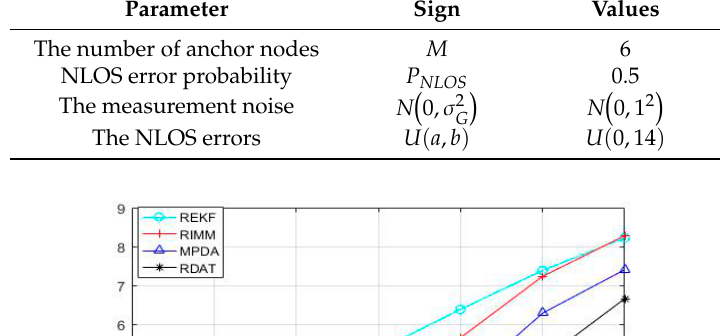
Table 2. Uniform distribution parameter.